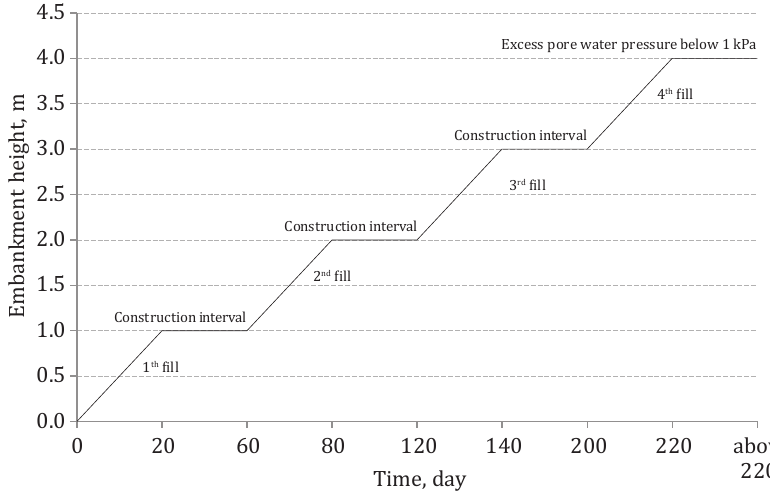
Figure 3. Construction